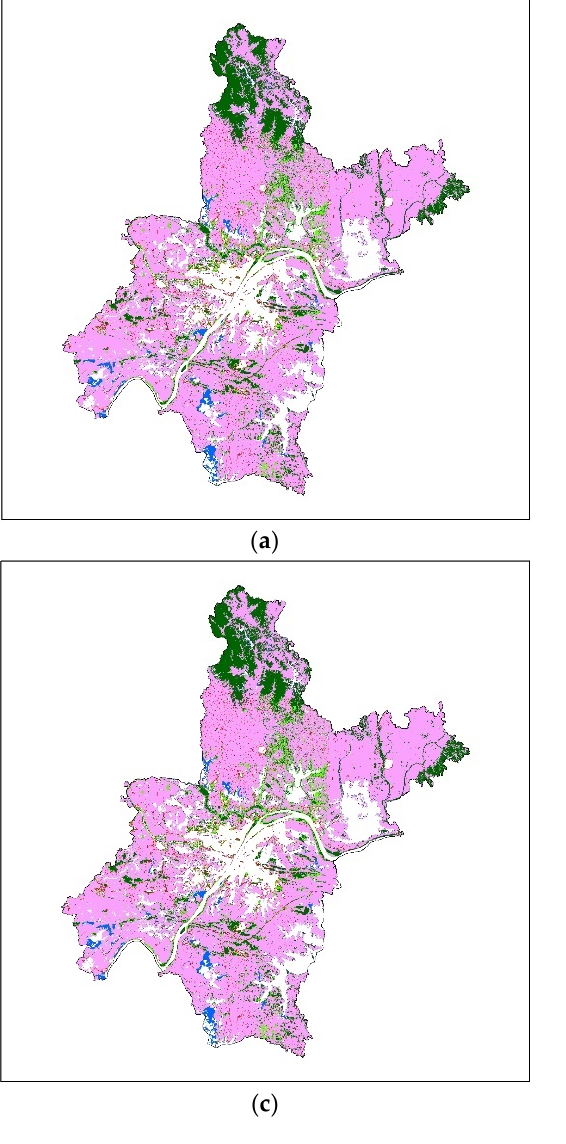
Figure 4. Locations of uncertainty: ( a ) those of mixed pixels, ( b ) those of relatively low OAs, and ( c ) union of locations shown in ( a , b ).